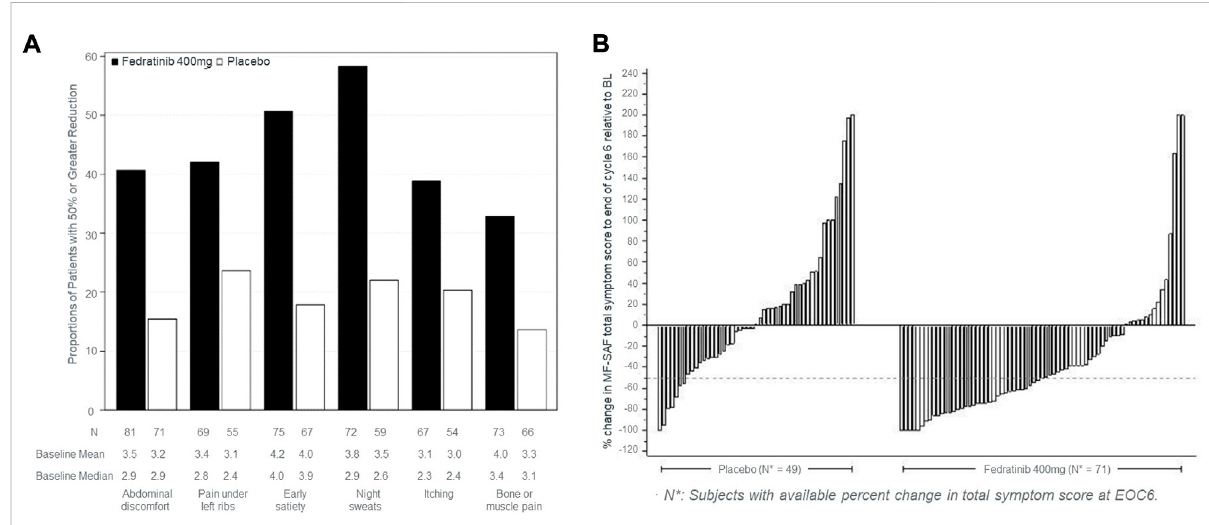
FIGURE 1 Type of graphs used in FDA labels to commnicate PROs. (A) Proportion of patients achieving ≥ 50% reduction in individual symptom scores at theendofcyclesixwithnon-zerobaselinescores. (B) Percentchangefrombaselineintotalsymptomscoreattheendofcyclesixforeachpatientin thephasethreestudy,JAKARTA.Thegraphsin (A,B) weretakenfromtheUSproductinsertoffedranitib(Inrebic ® ).Thesetwotypesofgraphsarealso included in the ruxolitinib (Jaka fi ® ) US product